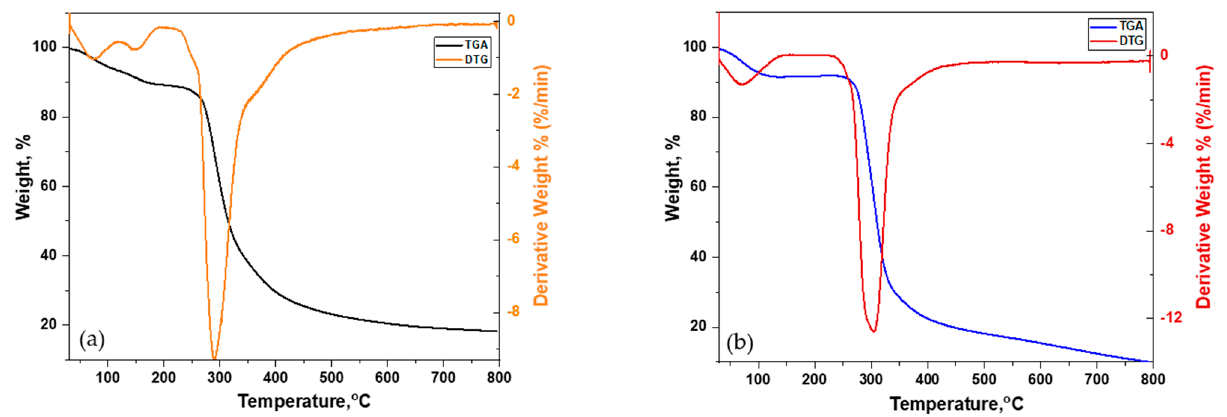
Figure 4. Thermograms of ( a ) Native Tapioca Starch (NTS) and ( b ) Carboxymethylated Tapioca Starch